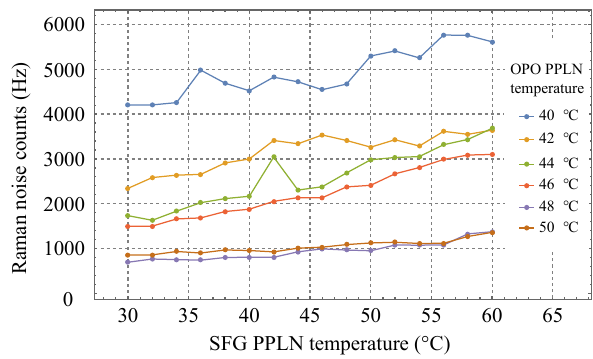
Figure 6: The Raman noises measurement results according to the SFG PPLN temperature with the six OPO PPLN’s temperature